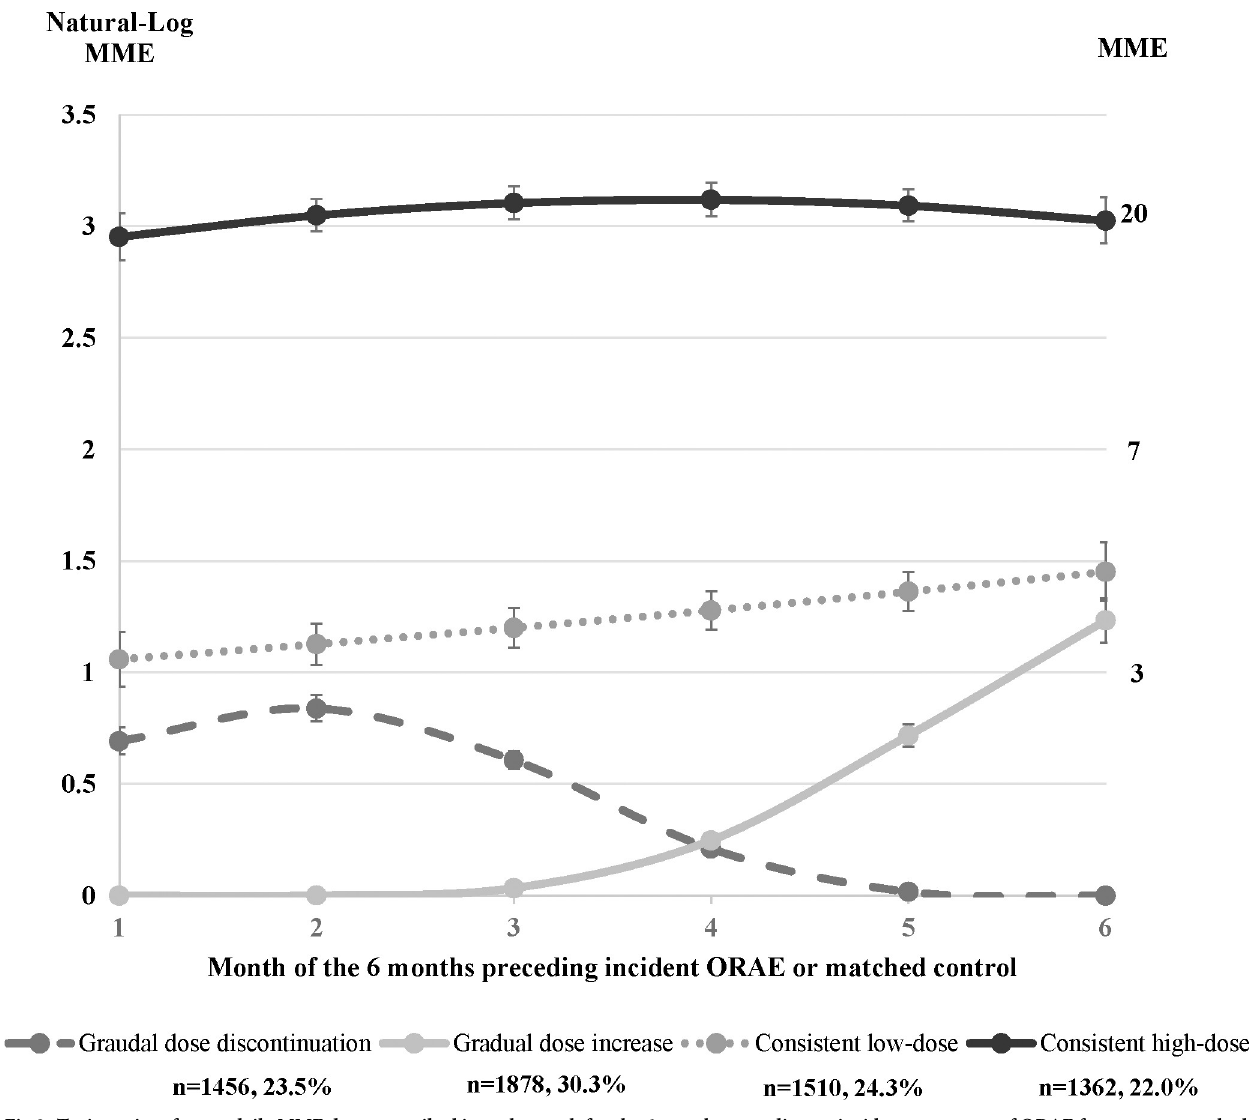
Fig 2. Trajectories of mean daily MME dose prescribed in each month for the 6 months preceding an incident encounter of ORAE for cases or matched controls of older adults. Lines represent types of dose trajectory group, and for each line, each point represents the mean daily MME of prescription opioids per month. The scale on the left and right side of the figure is the natural logarithm of MME and actual MME, respectively. The error bar represents the standard deviation of the natural logarithm transformed MME. MME, morphine milligram equivalent; ORAE, opioid-related adverse event.